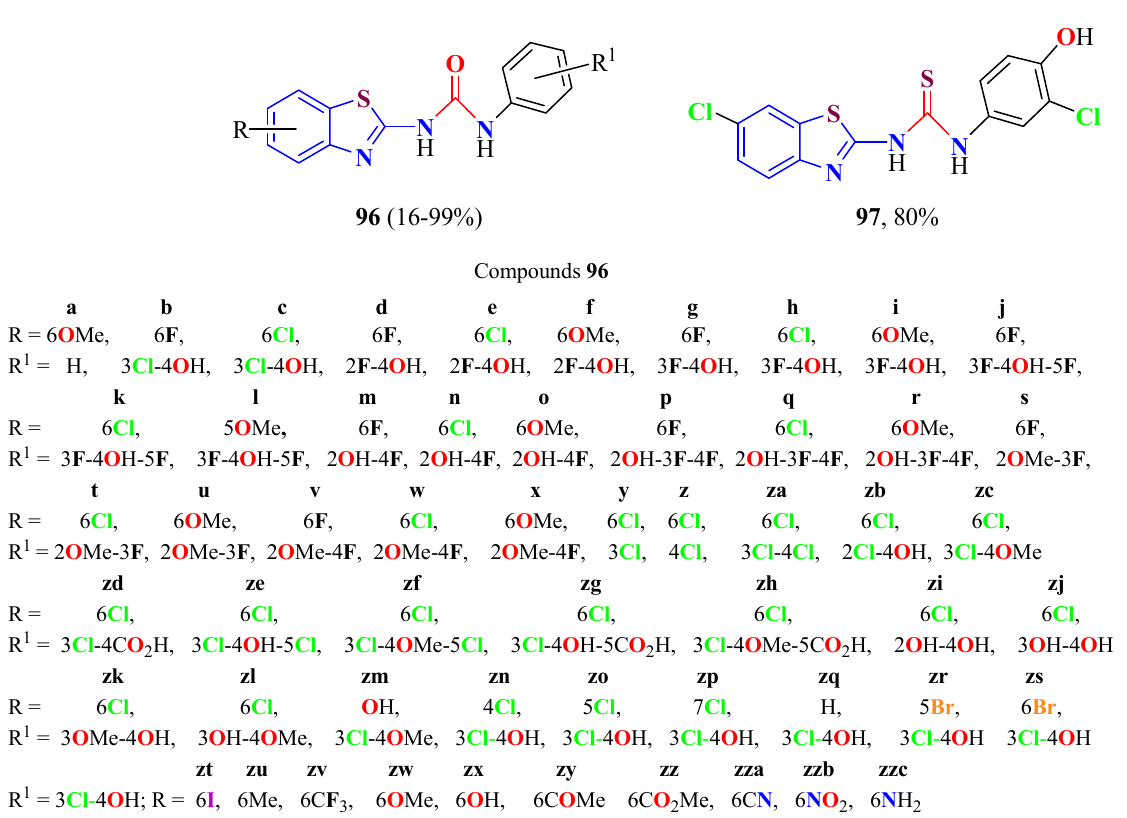
Figure 12. Substituted UBTs 96a – zzc and TBT 97 from substituted 2ABTs, CDI, or TCDI and aniline derivatives.